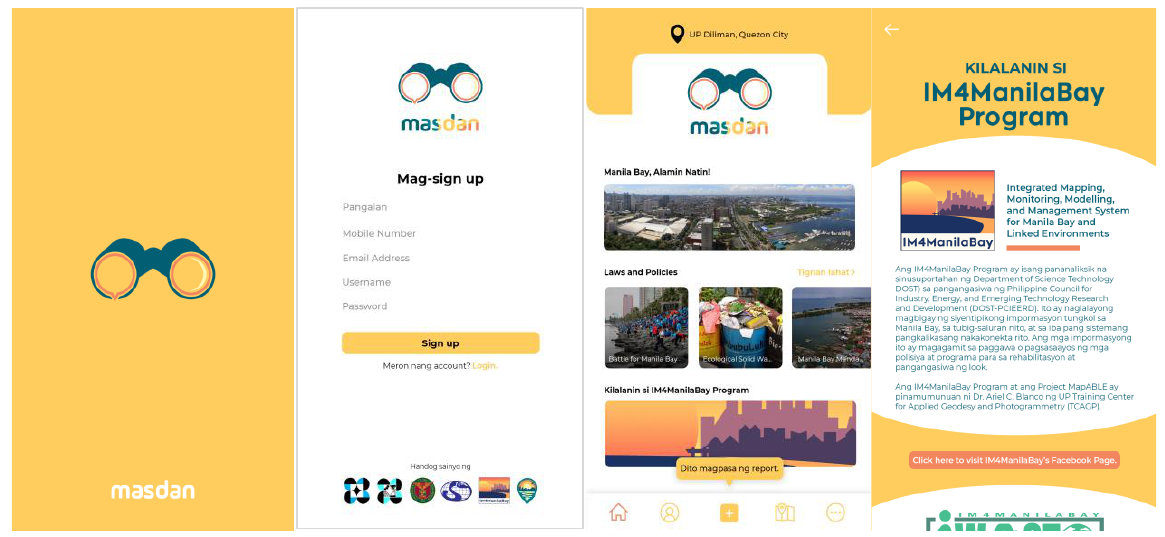
Figure 5. MASDAN Mobile Application user